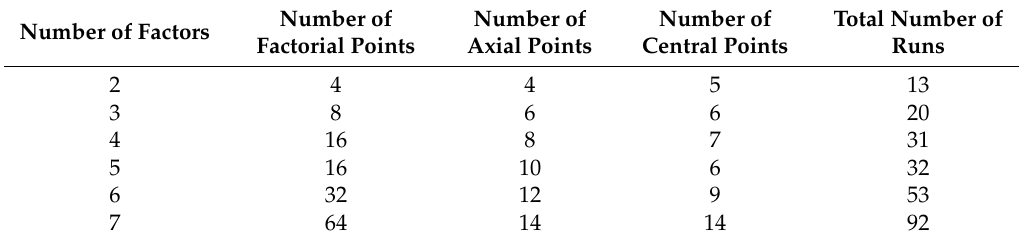
Table 6. Common CCD components and the possible total number of runs. Factorial, axial and central points are the main components of a typical CCD and the total number of runs is dictated by the number of factors being tested. As the number of factors increases, the number of component points increase and so the total number of runs. In some cases, CCDs do not contain axial points, especially when the variance of model prediction is not suspected [140]. Number of Number of Number of Total Number of Number of Factors Factorial Points Axial Points Central Points